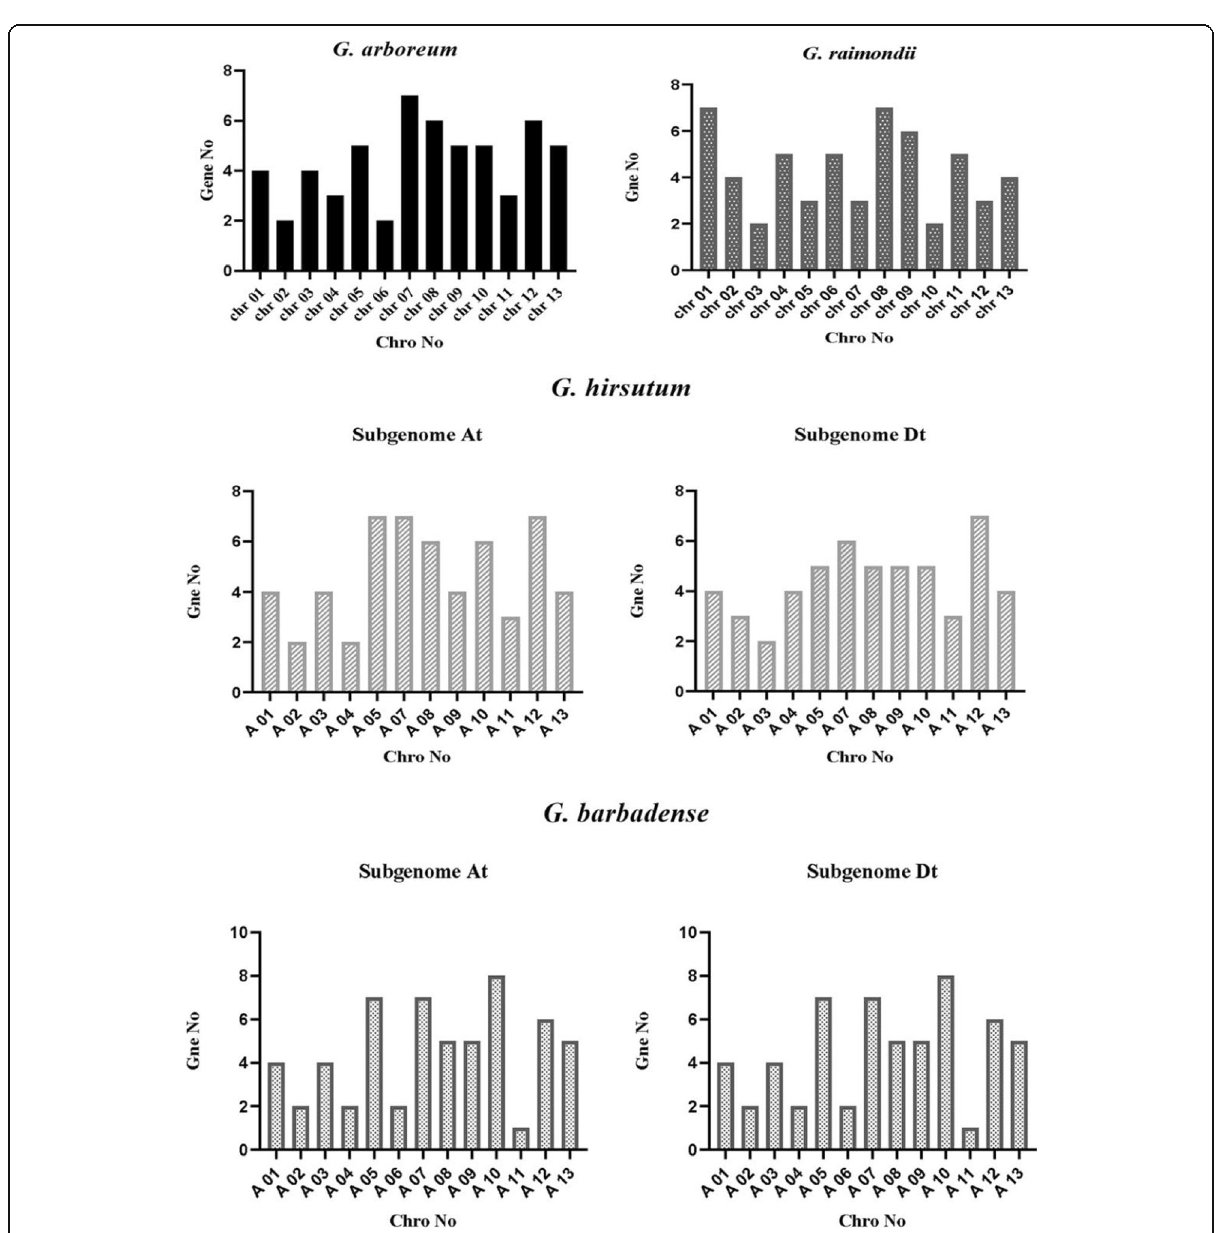
Fig. 4 Chromosomal distribution of upland cotton ZAT family. Note: The chromosome location is referred to the gff3 cotton genome